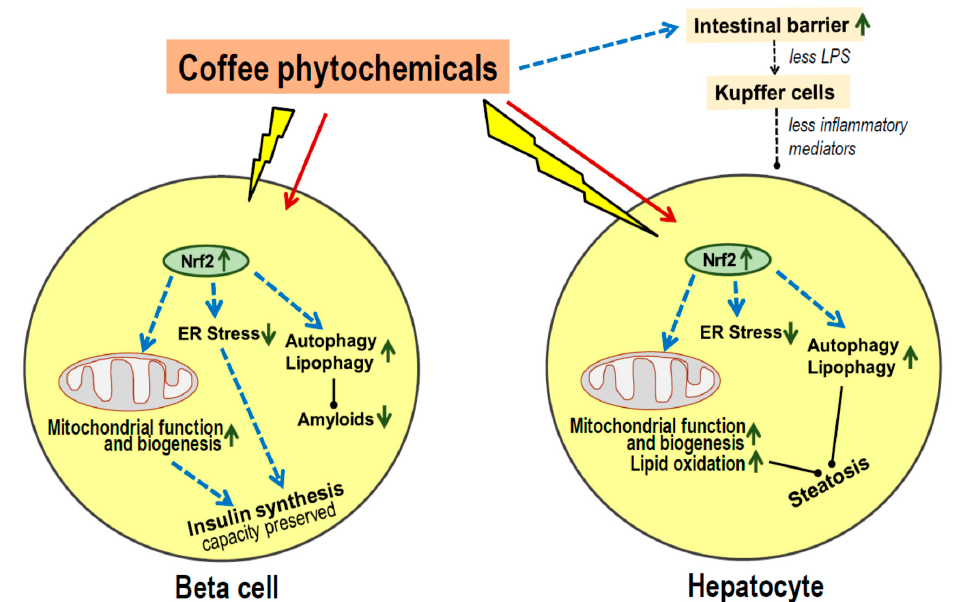
Figure 2. Protective action of coffee on metabolic stress in islet beta cells and hepatocytes. Exposure to coffee or its major constituents leads to activation of nuclear factor erythroid 2-related factor 2 (Nrf2), in vitro as well as in vivo. Enhanced expression of Nrf2 regulated genes leads to improved mitochondrial function and oxidation of lipids, and to mitigating of endoplasmic reticulum (ER) stress in cells during periods of increased peptide synthesis. In beta cells, the insulin production capacity is further preserved by eliminating aggregates of misfolded proinsulin or amylin by increased autophagy, and by prevention of aggregation by binding of coffee phytochemicals to hydrophobic surface regions exposed by misfolded peptides. In hepatocytes, metabolic activity is preserved and steatosis prevented by improved mitochondrial beta-oxidation of fatty acids, increased autophagy for lipid disposal and less inflammatory stress from activated Kupffer cells because of less lipopolysaccharide (LPS) leakage from the colon. ↑ , upregulation; ↓ downregulation